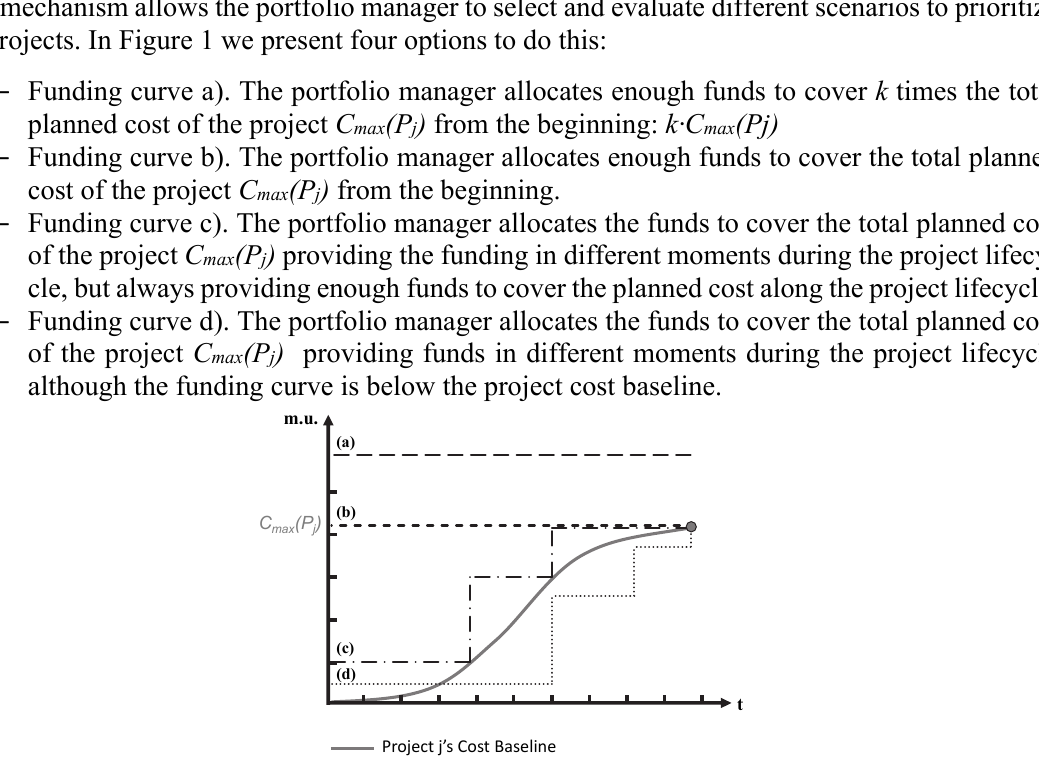
Fig. 1. Four options to select the funding (i.e. priority) of the project j within the portfolio (mu: monetary